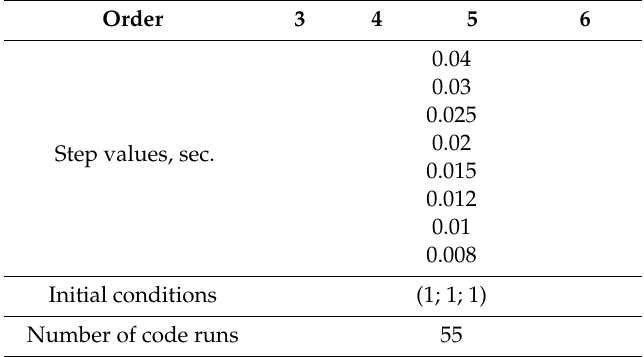
Table 4. Parameters used in experiments with the Sprott Case A system.